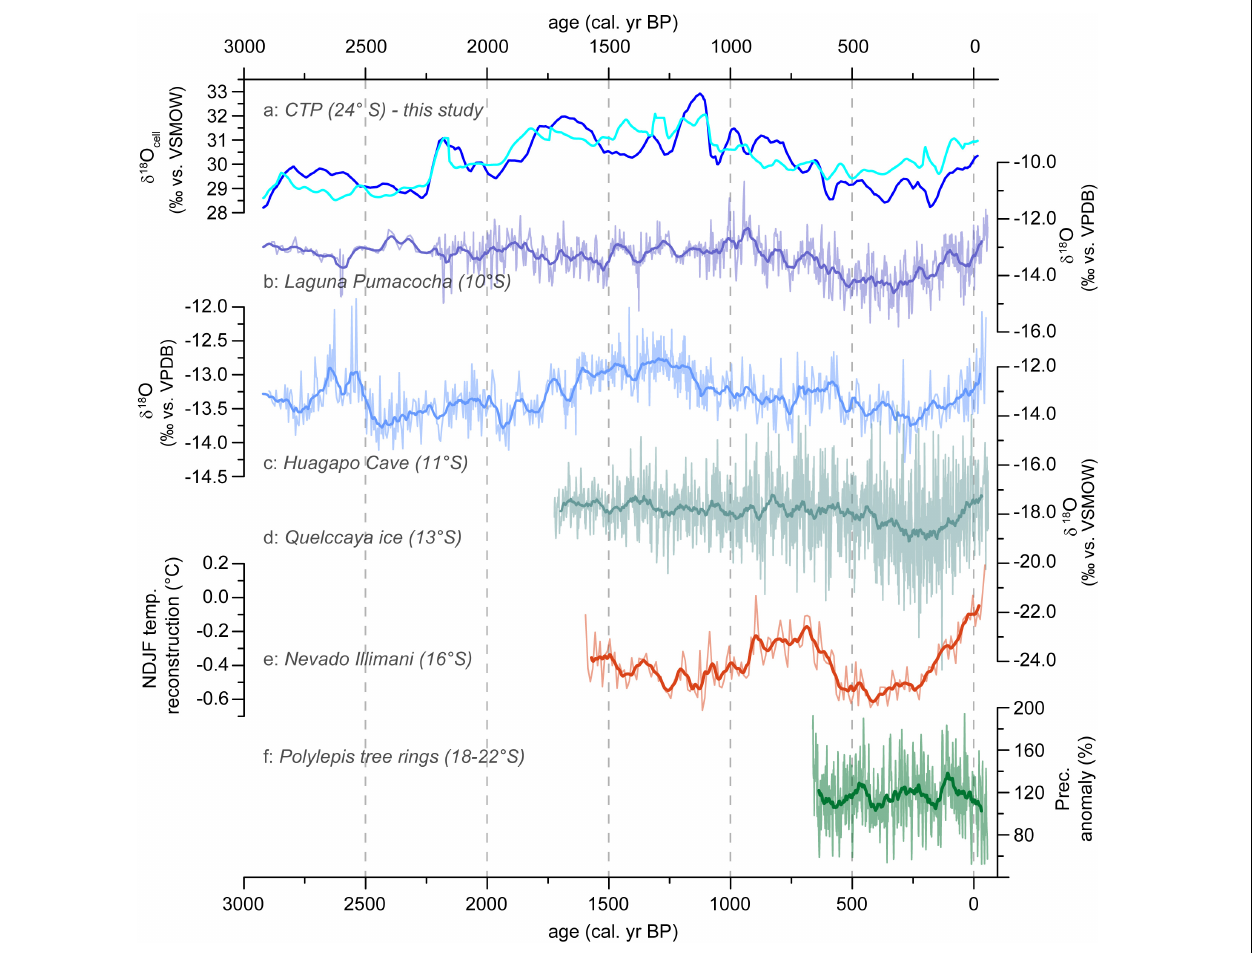
vs. VSMOW) for fraction 200–1000 µ m (dark blue) and fraction > 1000 µ m (cid:104)